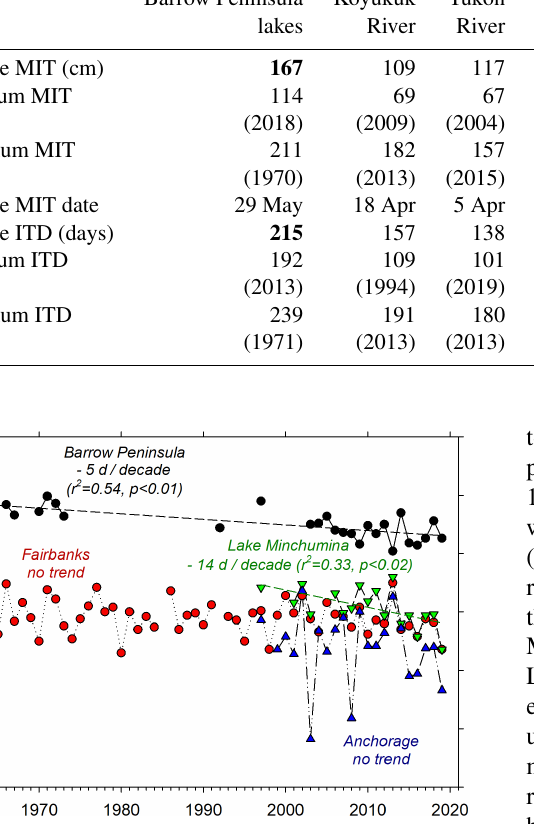
Figure 6. Ice travel duration on lakes estimated from ice growth curves for each period of